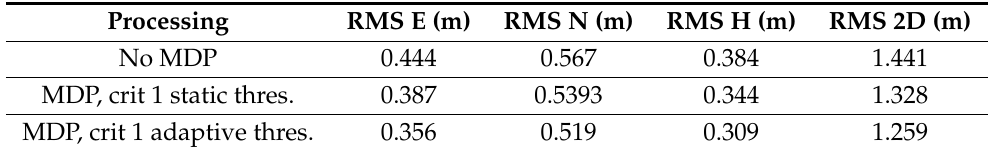
Table 4. Comparison between RMS obtained after MDP application, criterion 1, during multipath- induced interval.